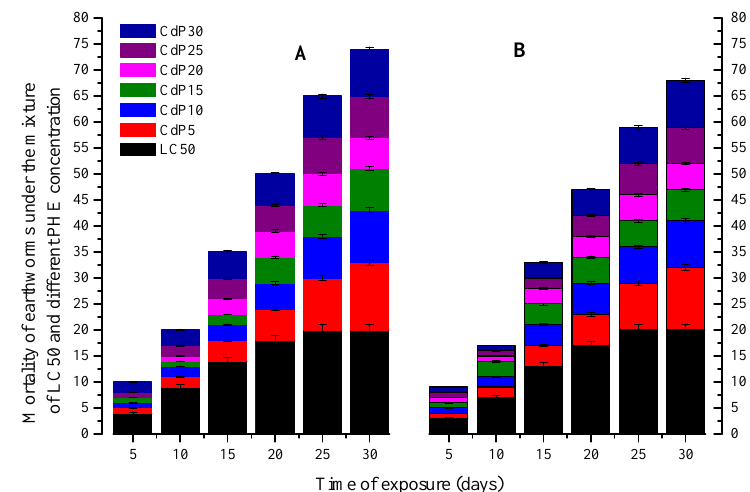
Figure 3. Mortality effect of LC50 values in the mixture treatment with phenanthrene different concentration (5, 10, 15, 20, 25 and 10 mg kg − 1 ) on E fetida ( A ) and A. caliginosa ( B ).